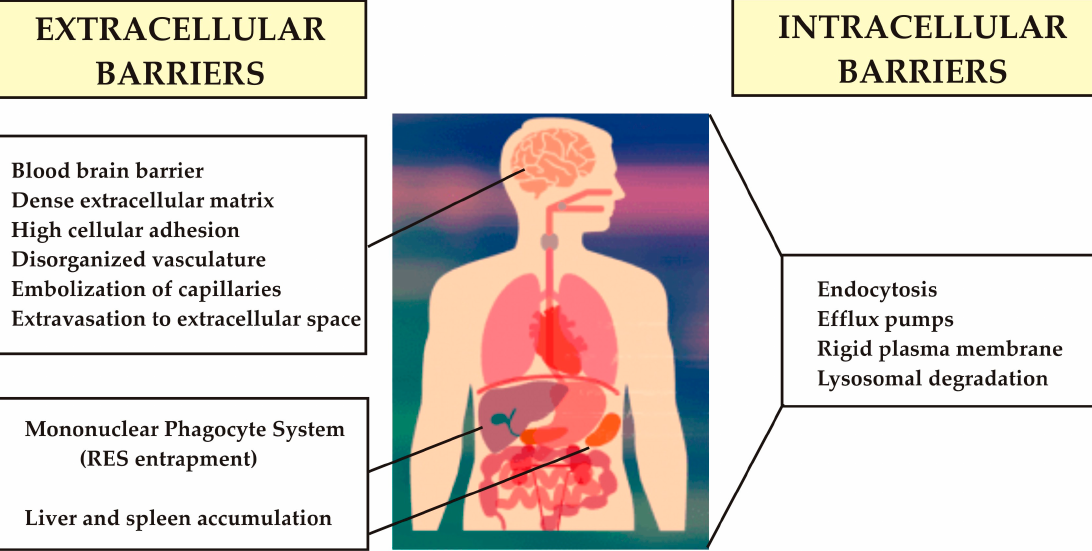
Figure 4. Biological barriers.